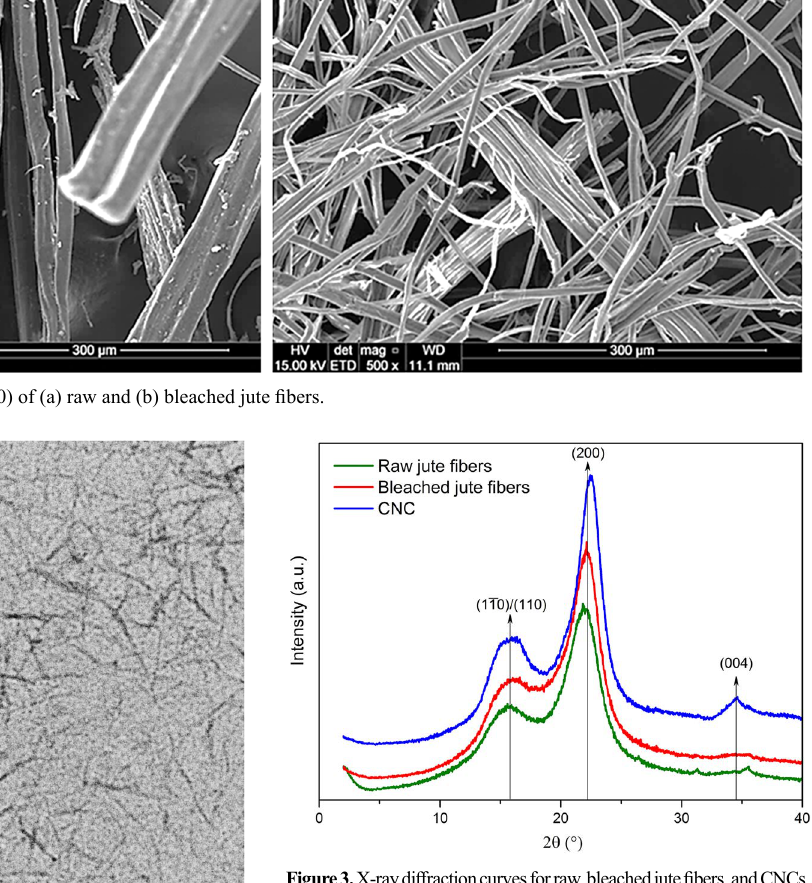
Figure 3. X-ray diffraction curves for raw, bleached jute fibers, and CNCs.